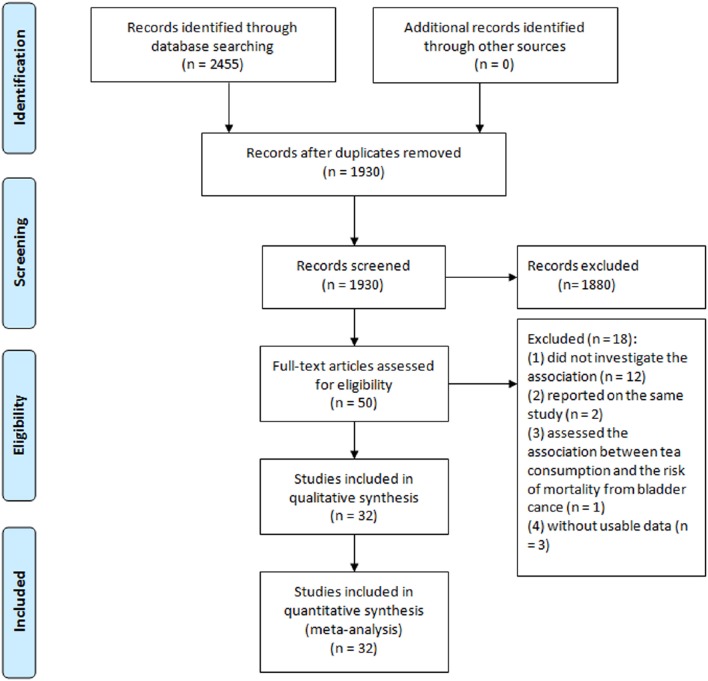
Flow diagram of literature search and study selection.